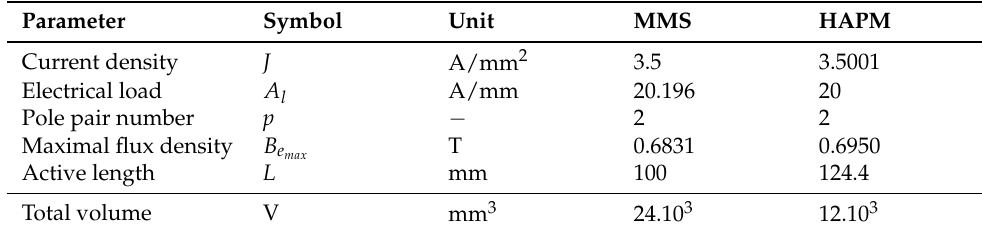
Table 5. Optimal parameters and optimized volume.